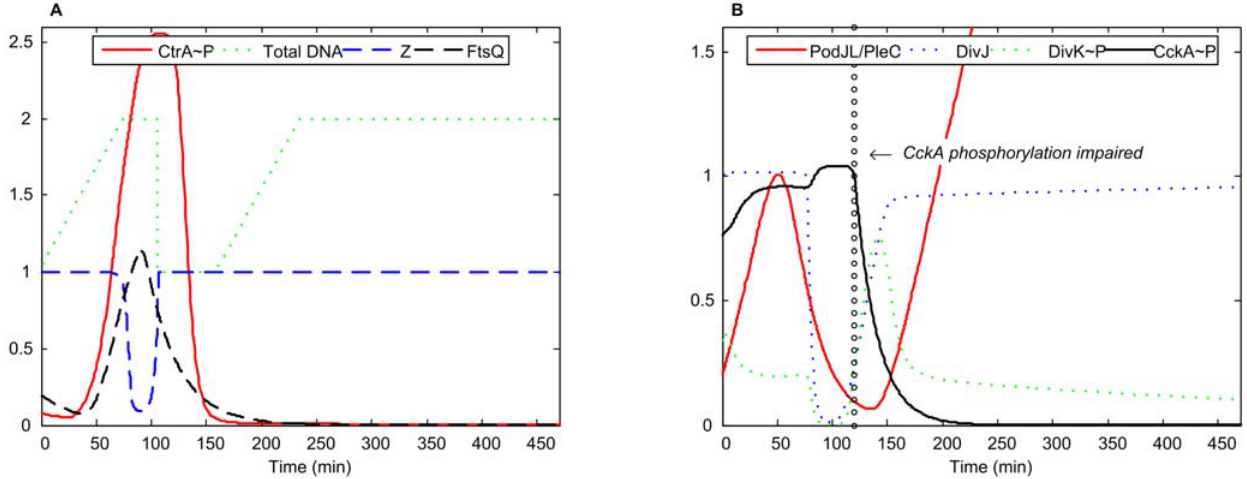
Figure 13. Simulation of unphosphorylated CckA mutant. k trans,CckA =0.